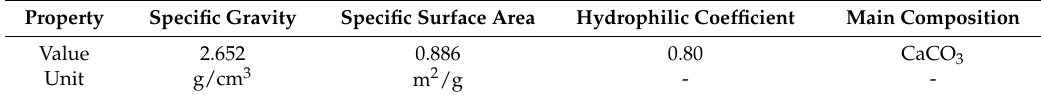
Table 2. Properties of limestone powder.